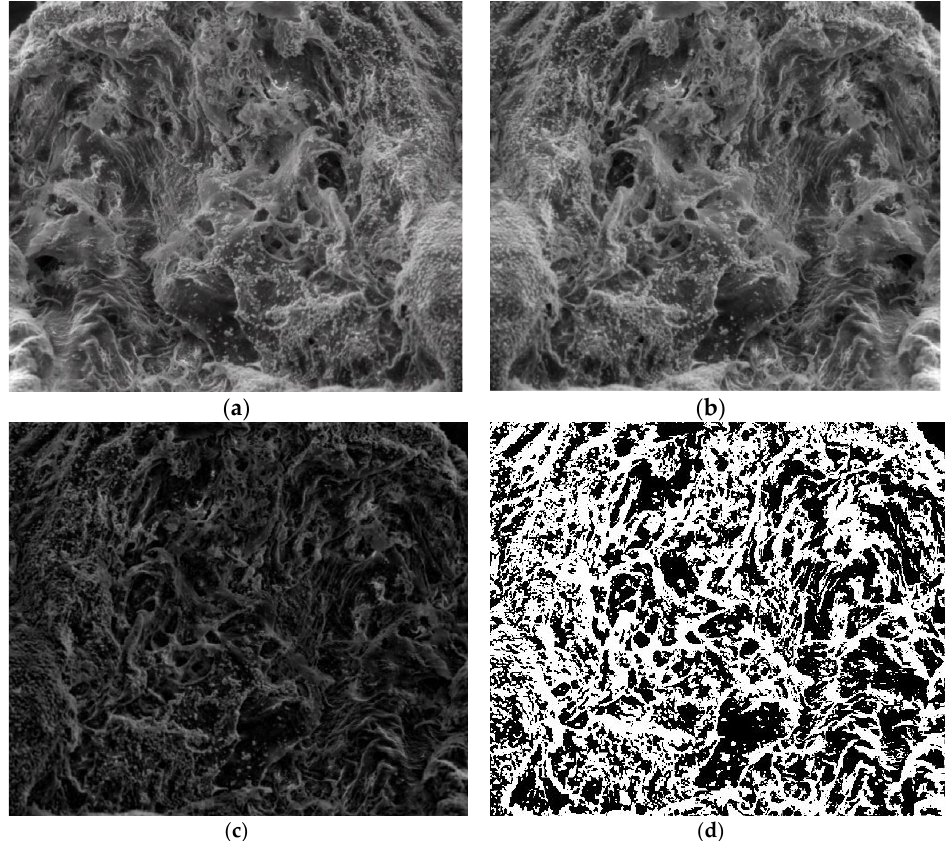
Figure 7. Processing stages of P 1 image. ( a ) Original image (the entire portion); ( b ) grayscale version; ( c ) grayscale version without luminance; ( d ) binarized version.